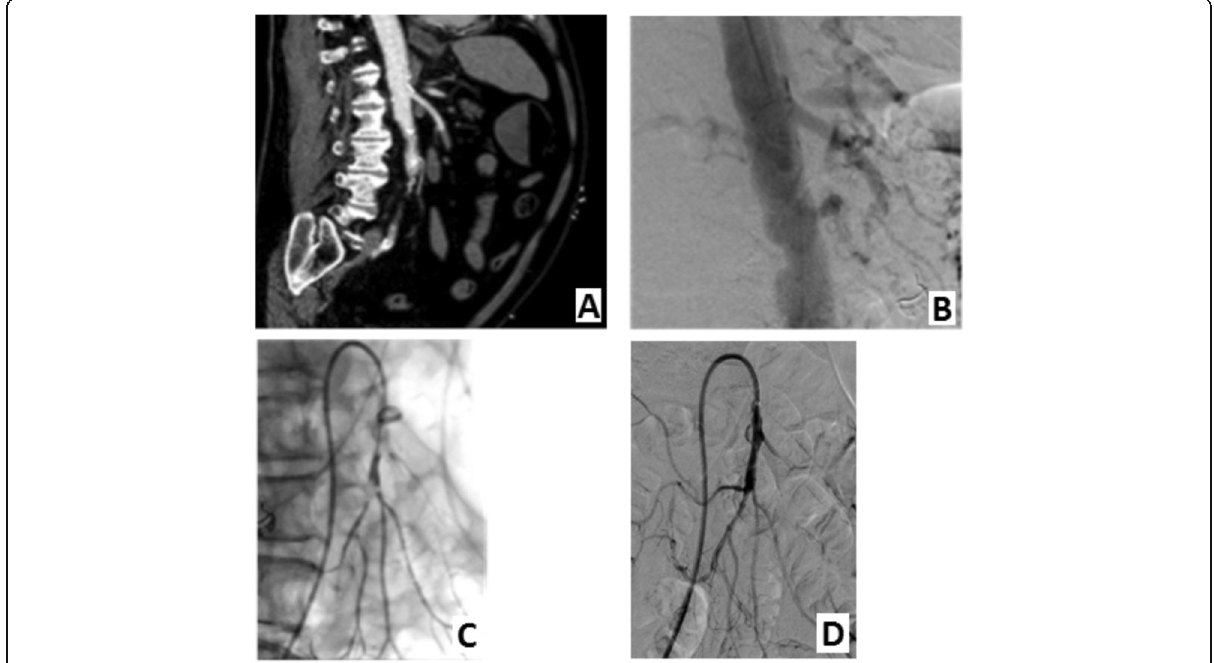
Fig. 1 SMA embolism, occlusion main trunk and ileicolic artery ( a ) Sagittal CT image, arterial phase, main stem occlusion. b Lateral view DSA acute stop proximal in the SMA. c Selective SMA angiography after thrombosuction shows improved patency but residual thrombus in main stem SMA and ileocolic artery. d After PTA of ileocolic artery and main stem SMA followed by stent placement in main stem SMA shows patent SMA and side